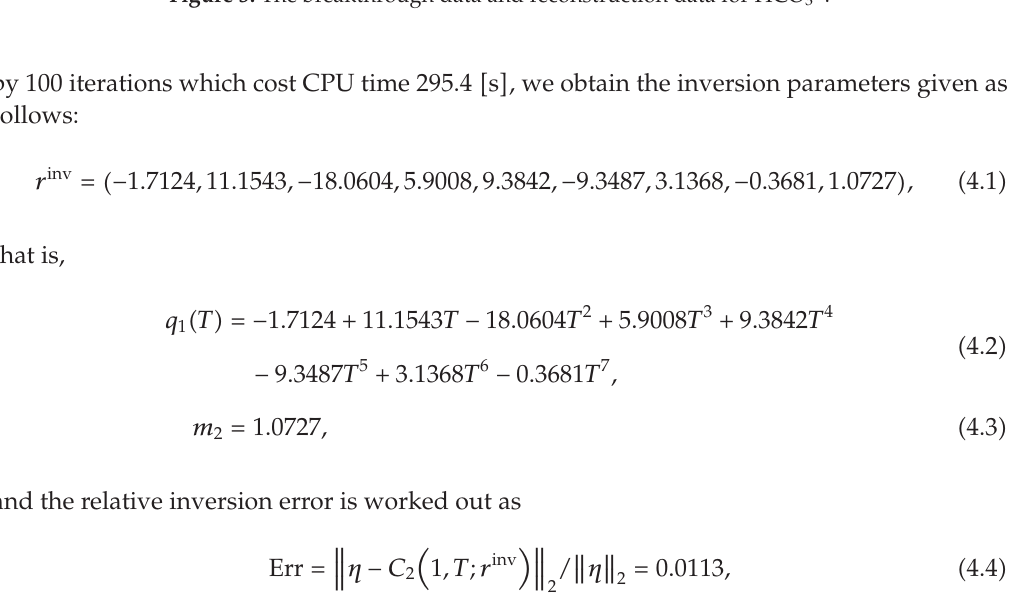
Figure 3: The breakthrough data and reconstruction data for HCO 3 −